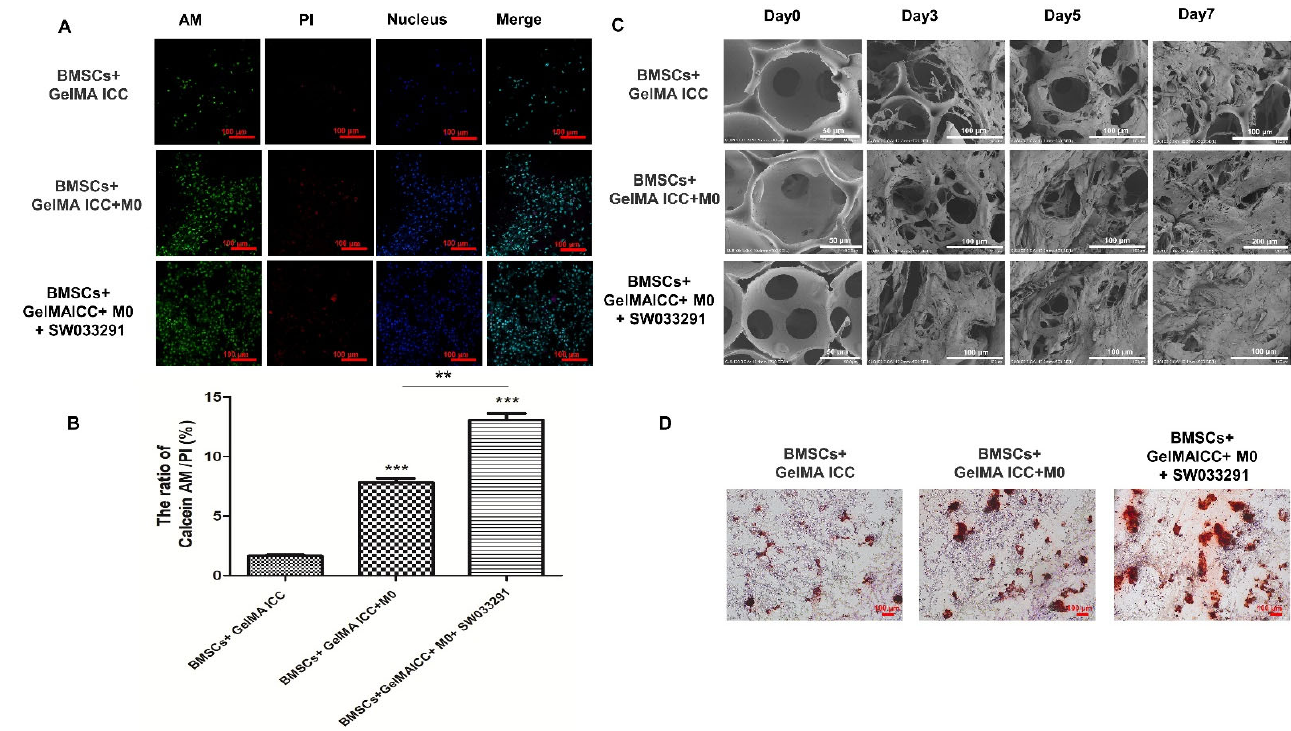
Figure 4. Effects of GelMA ICC with SW033291 on the cell viability, morphologies, and differentiation of BMSCs in co- culture. ( A ) The cell activity of BMSCs in coculture treated with GelMA ICC/SW033291 detected by Calcein AM (live cells in green)/PI (dead cells in red); ( B ) The ratios of live cells and death cells; ( C ) Characterization of BMSCs morphologies in GelMA ICC scaffolds during the culture in different groups; ( D ) The images of the Alizarin red staining in different groups. Data represent mean ± standard deviation, n = 3. The BMSCs seeded on GelMA ICC was served as the control, ** p < 0.05 significant difference as compared groups. *** p < 0.01 vs. the control group.